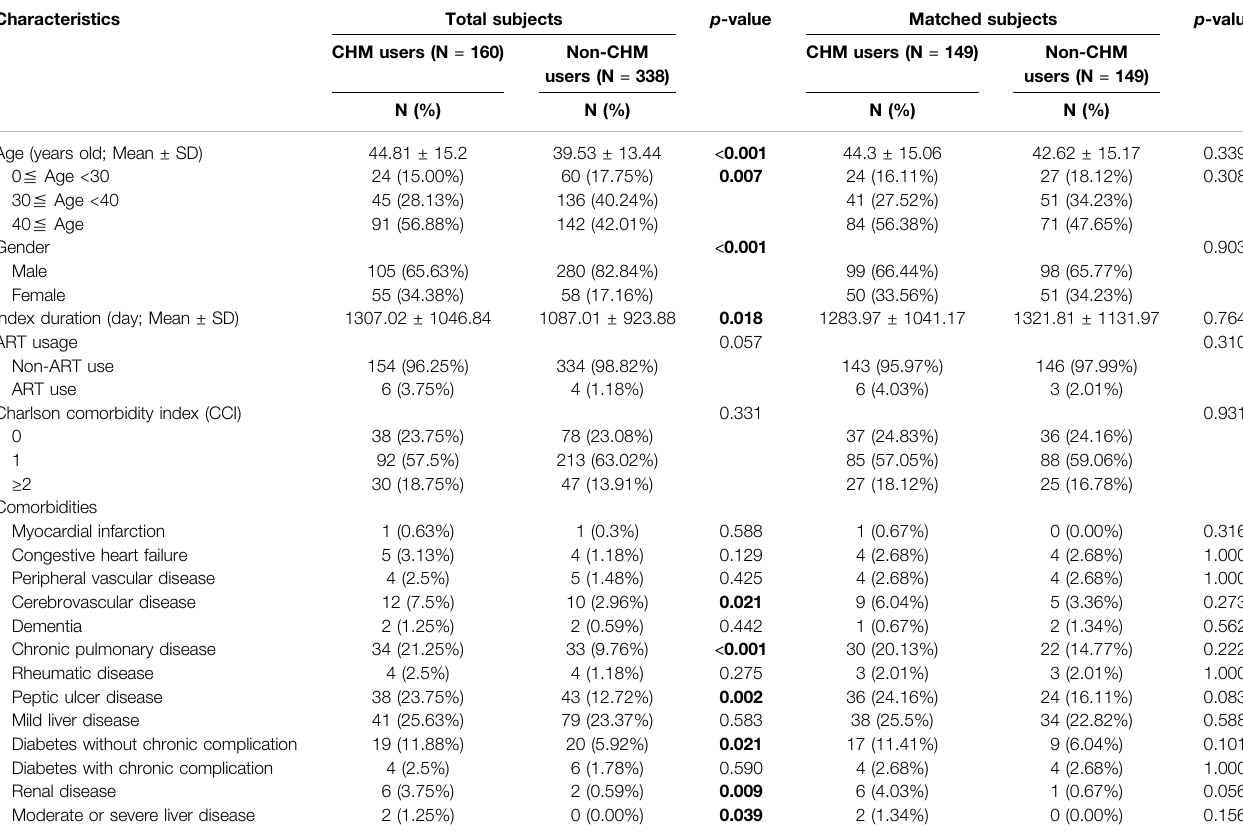
TABLE 1 | Demographic characteristics of HIV-infected patients with osteoporosis or fractures according to Chinese herbal medicine usage in Taiwan.